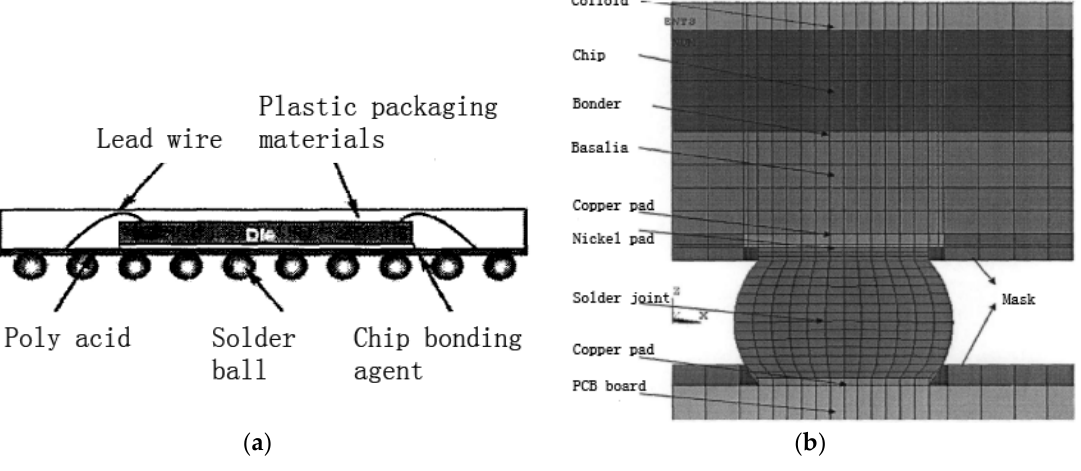
Figure 4. Structure diagram of MROM TF-BGA48: ( a ) Chip level structure; ( b ) Micro-structure of BGA solder joint. Table 1. Information of MROM